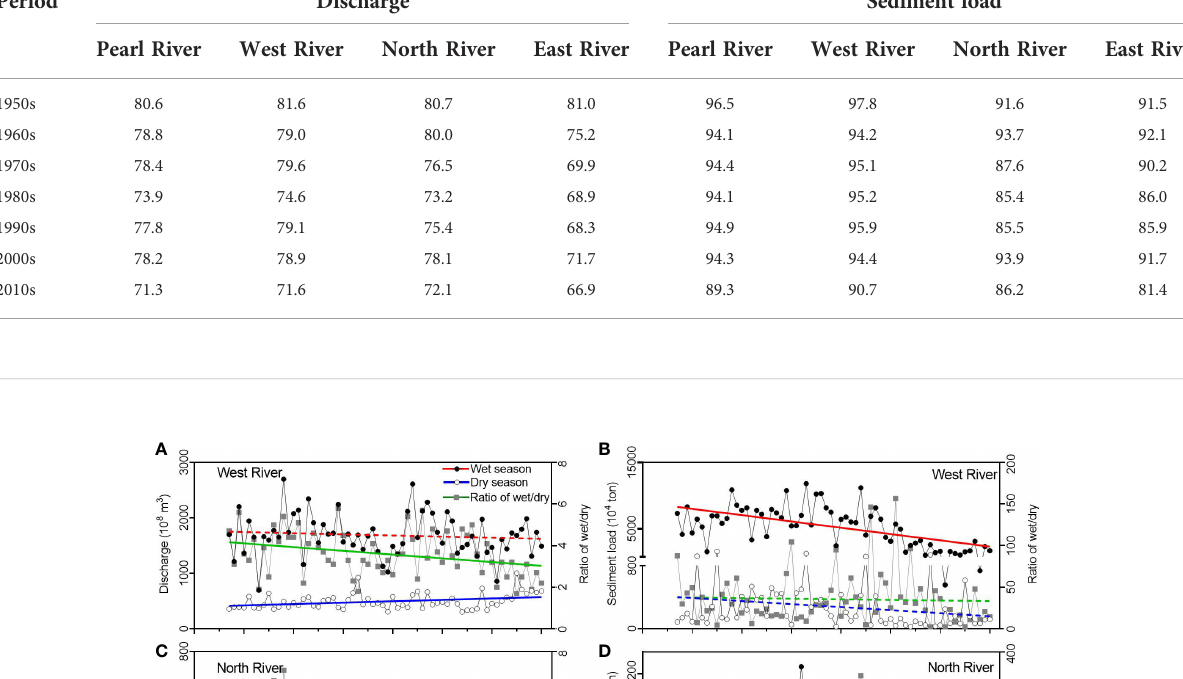
TABLE 5 Percentages (%) of the wet-season discharge and sediment load accounting for the annual amount during different periods. Period